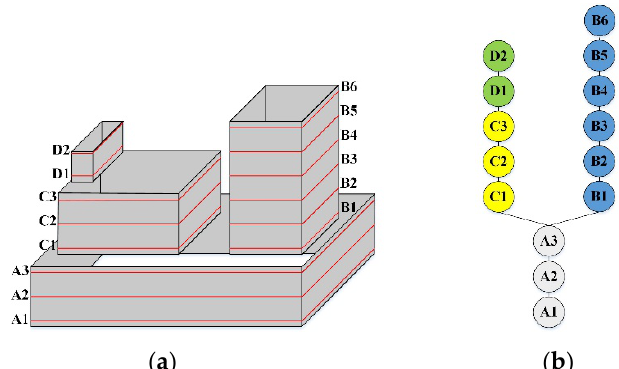
Figure 2. An illustration of the local contour tree of the photogrammetric mesh model: ( a ) contours tracking results; ( b ) local contour tree generation result.